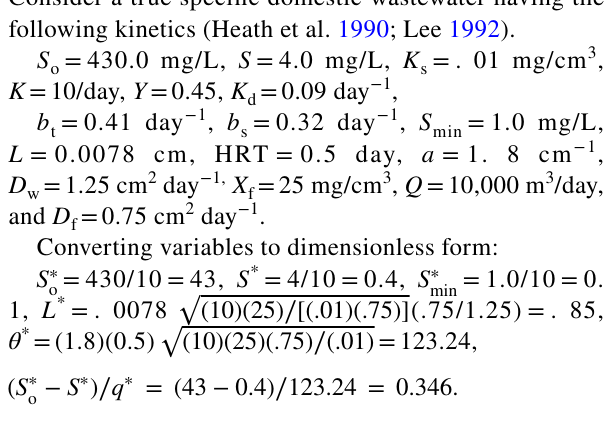
Fig. 5 SRT * as a function of S * and ( S ∗ o − S )/HRT at Y K / K L * = 1.0, S ∗ min =